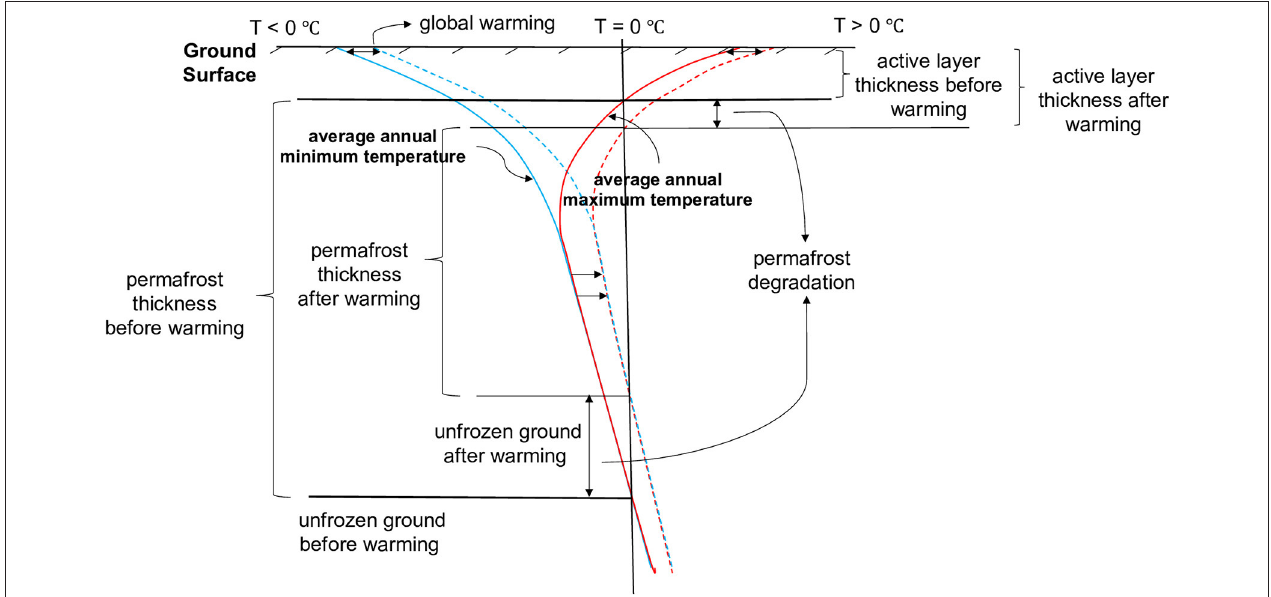
FIGURE 1 | Permafrost degradation induced by a warming climate. Modified after Dobinski (2011). Dashed lines represent the temperature profiles for warmer climate conditions; an increase in temperature leads to permafrost degradation and an increase in active layer